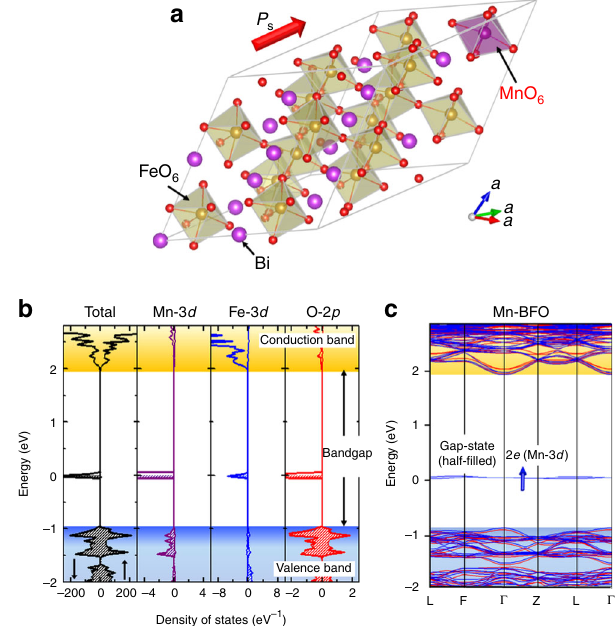
Fig. 2 Crystal and electronic structures of Mn-doped BFO. a Optimized crystal structure of Mn-doped BFO [Bi 16 (Fe 15 Mn)O 48 ] in rhombohedral R 3 symmetry, b total density of states (DOS) and partial DOS (PDOS) of Mn-3 d , Fe-3 d and O-2 p and c electronic band structure. In b , the nearest neighbour Fe and O atoms of Mn are selected, and majority- and minority- spin bands are described in the right ( ↑ ) and left ( ↓ ) panels,